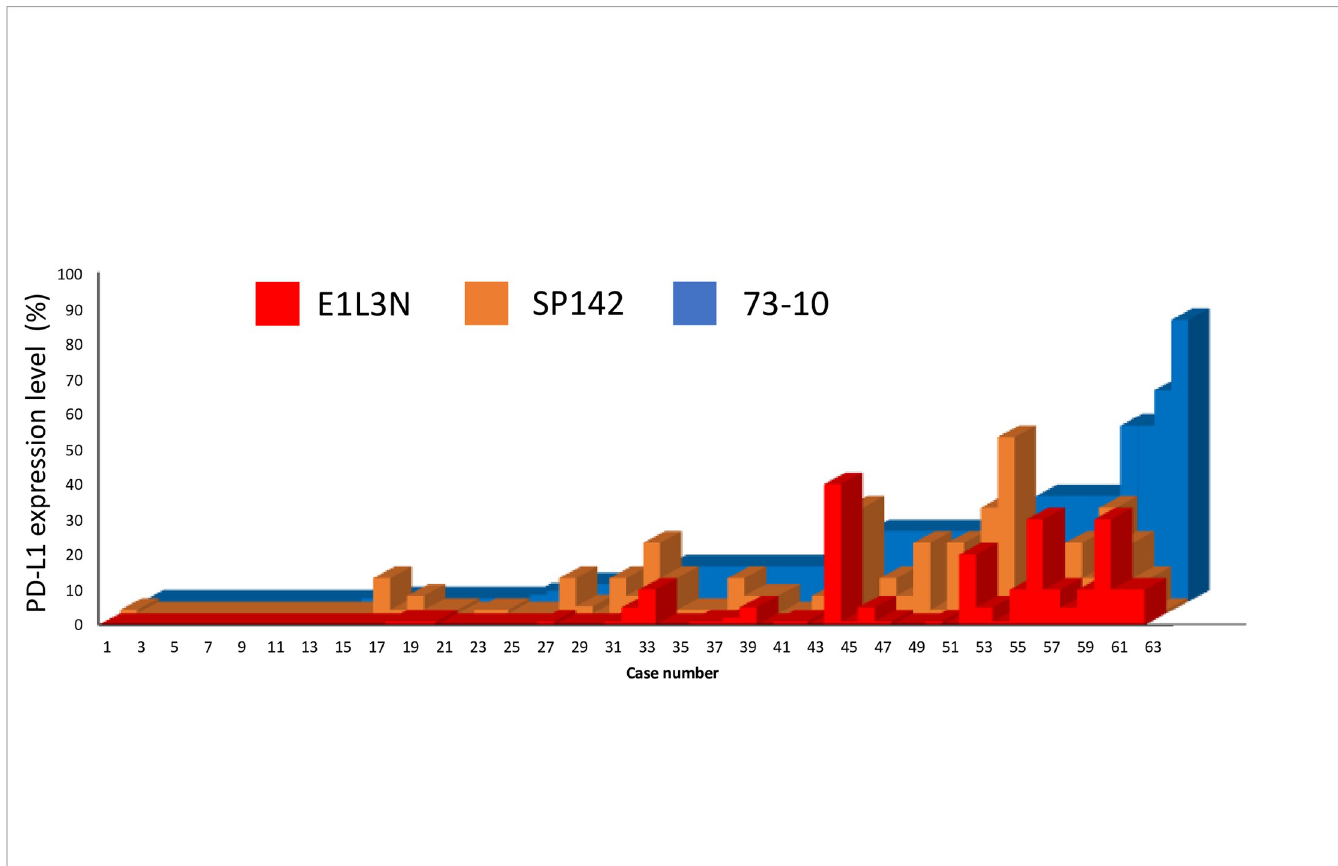
Fig 4. Comparison of PD-L1 expression level on immune cells using the 73–10, SP142, and E1L3N assays.